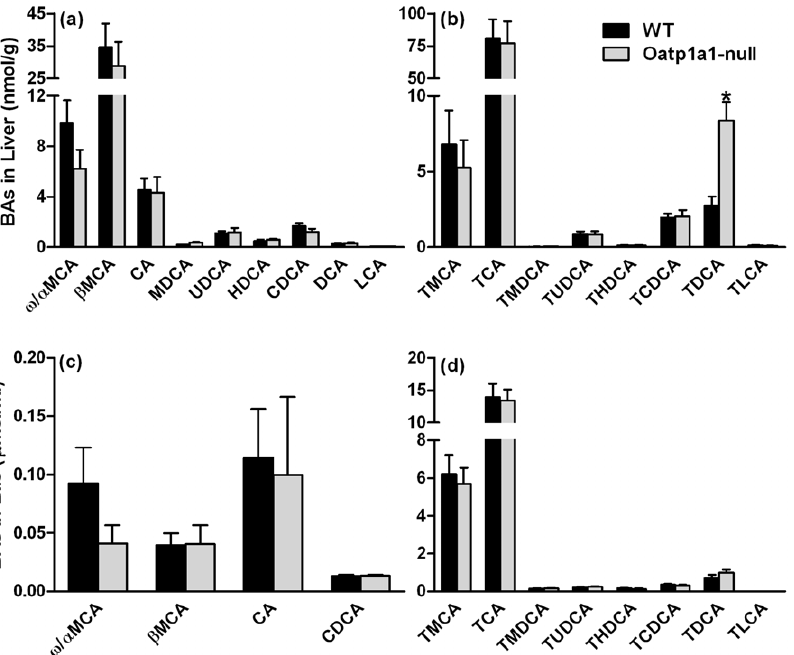
Figure 3. BA concentrations in livers (a and b) and bile (c and d) of mice. BA concentrations in livers and bile of male WT and Oatp1a1-null mice (n=5/group) were analyzed using ultra performance liquid chromatography-tandem mass spectrometry (UPLC-MS/MS). All data are expressed as mean 6 S.E. for five mice in each group. *, statistically significant difference between WT and Oatp1a1-null mice ( p , 0.05).